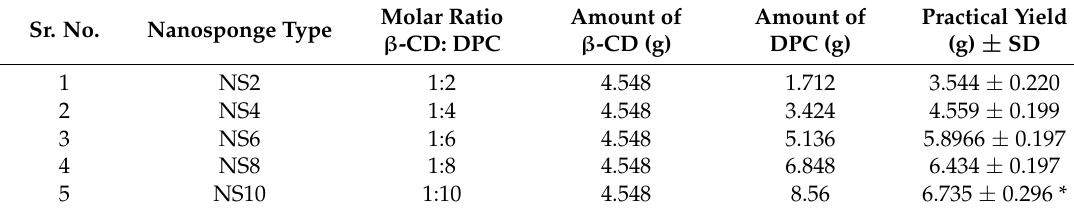
Table 1. Molar ratios of β -cyclodextrin and diphenyl carbonate ( n = 3, mean ± SD). Sr.